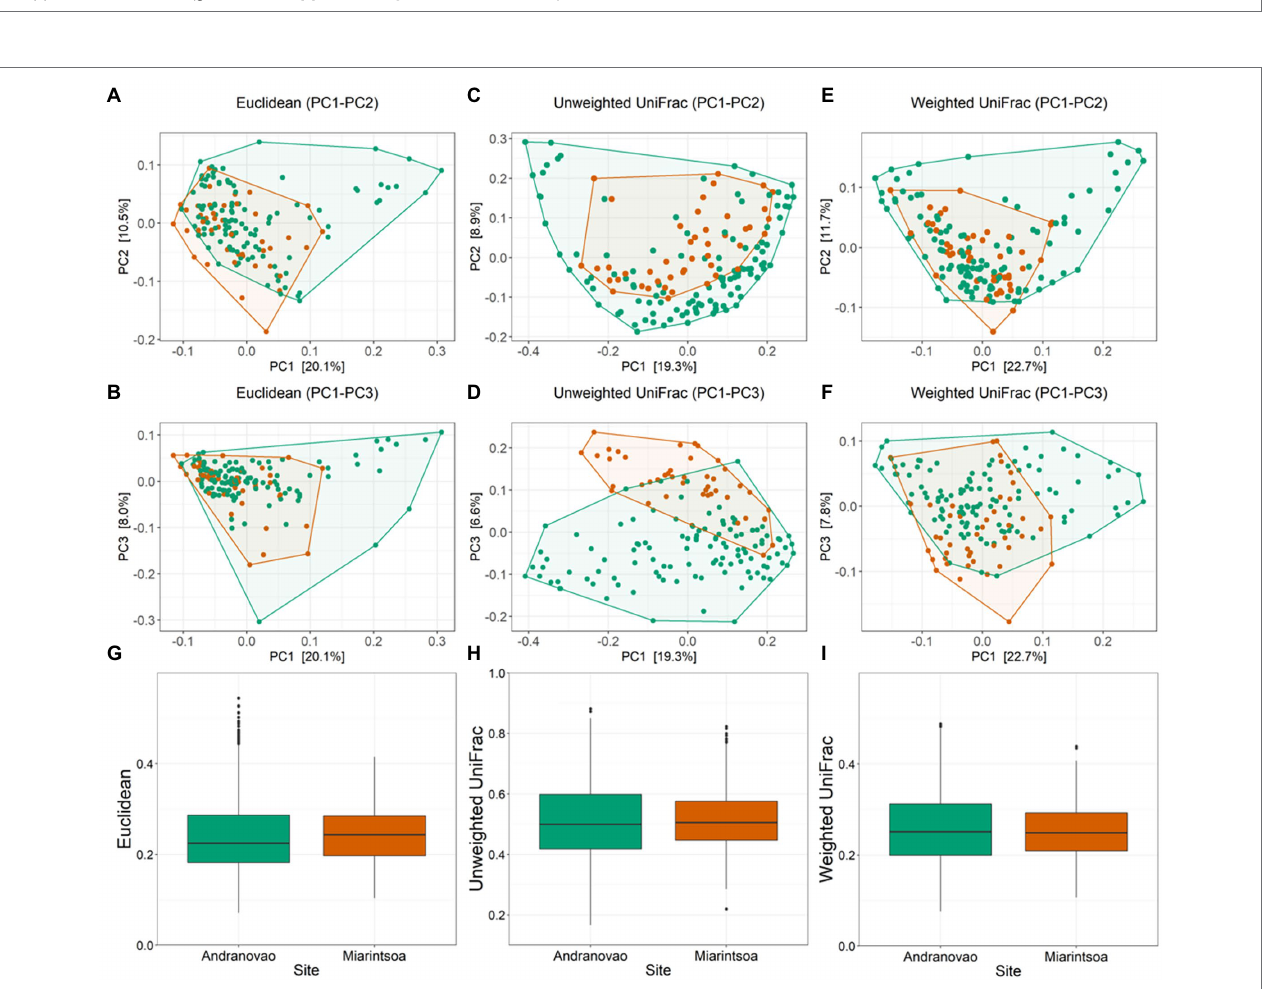
FIGURE 3 | Composition of bacterial community in the gut of mouse lemurs differs between habitats. Principal-coordinate plots of Euclidean [ (A) PC1–PC2, (B) PC1–PC3; Unweighted UniFrac (C) PC1–PC2, (D) PC1–PC3; and Weighted UniFrac (E) PC1–PC2, (F) PC1–PC3] metrics in mouse lemurs. Dots and connecting polygons represent bacterial communities in gut of mouse lemurs trapped in Andranovao (green) or Miarintsoa (red). Box plots are showing the inter- individual distances between Andranovao and Miarintsoa individuals using (G) Euclidean, (H) Unweighted UniFrac, and (I) Weighted UniFrac